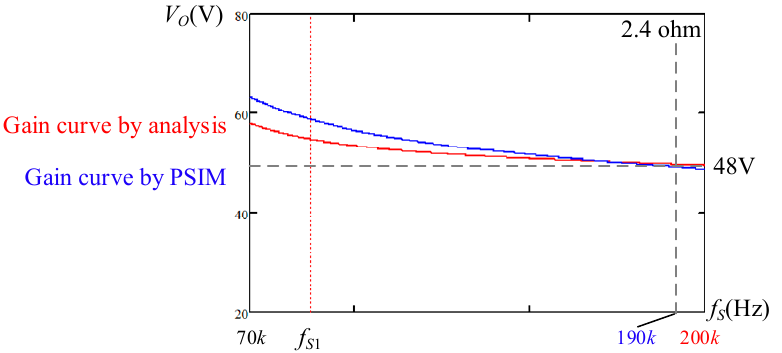
Figure 18. Gain curve comparison at 20% load.